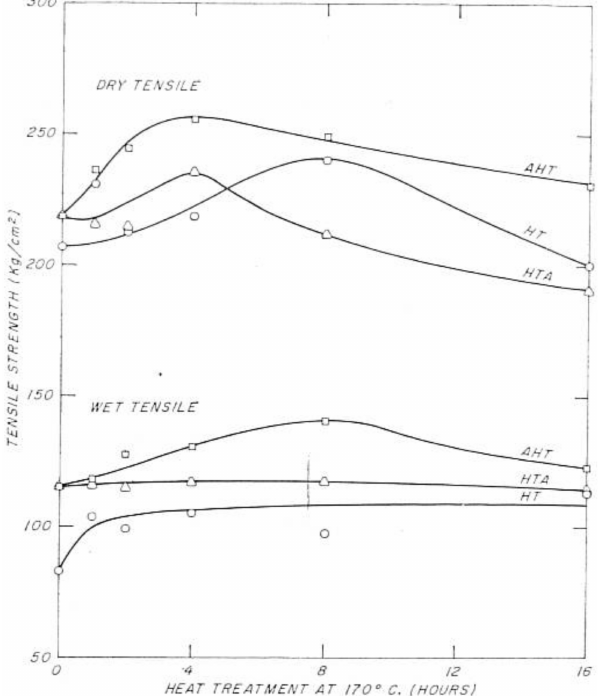
Figure 12. Dry and wet tensile strengths of hardboards (HT) heat-treated only, (AHT) acetylated and then heated, (HTA) heat-treated and then acetylated [16].